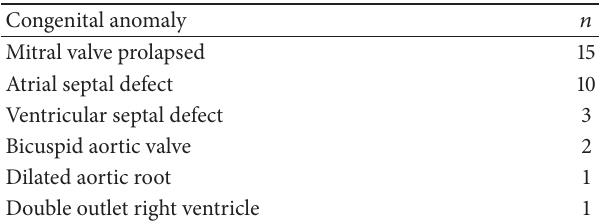
Table 2: Congenital cardiac anomalies detected by screening